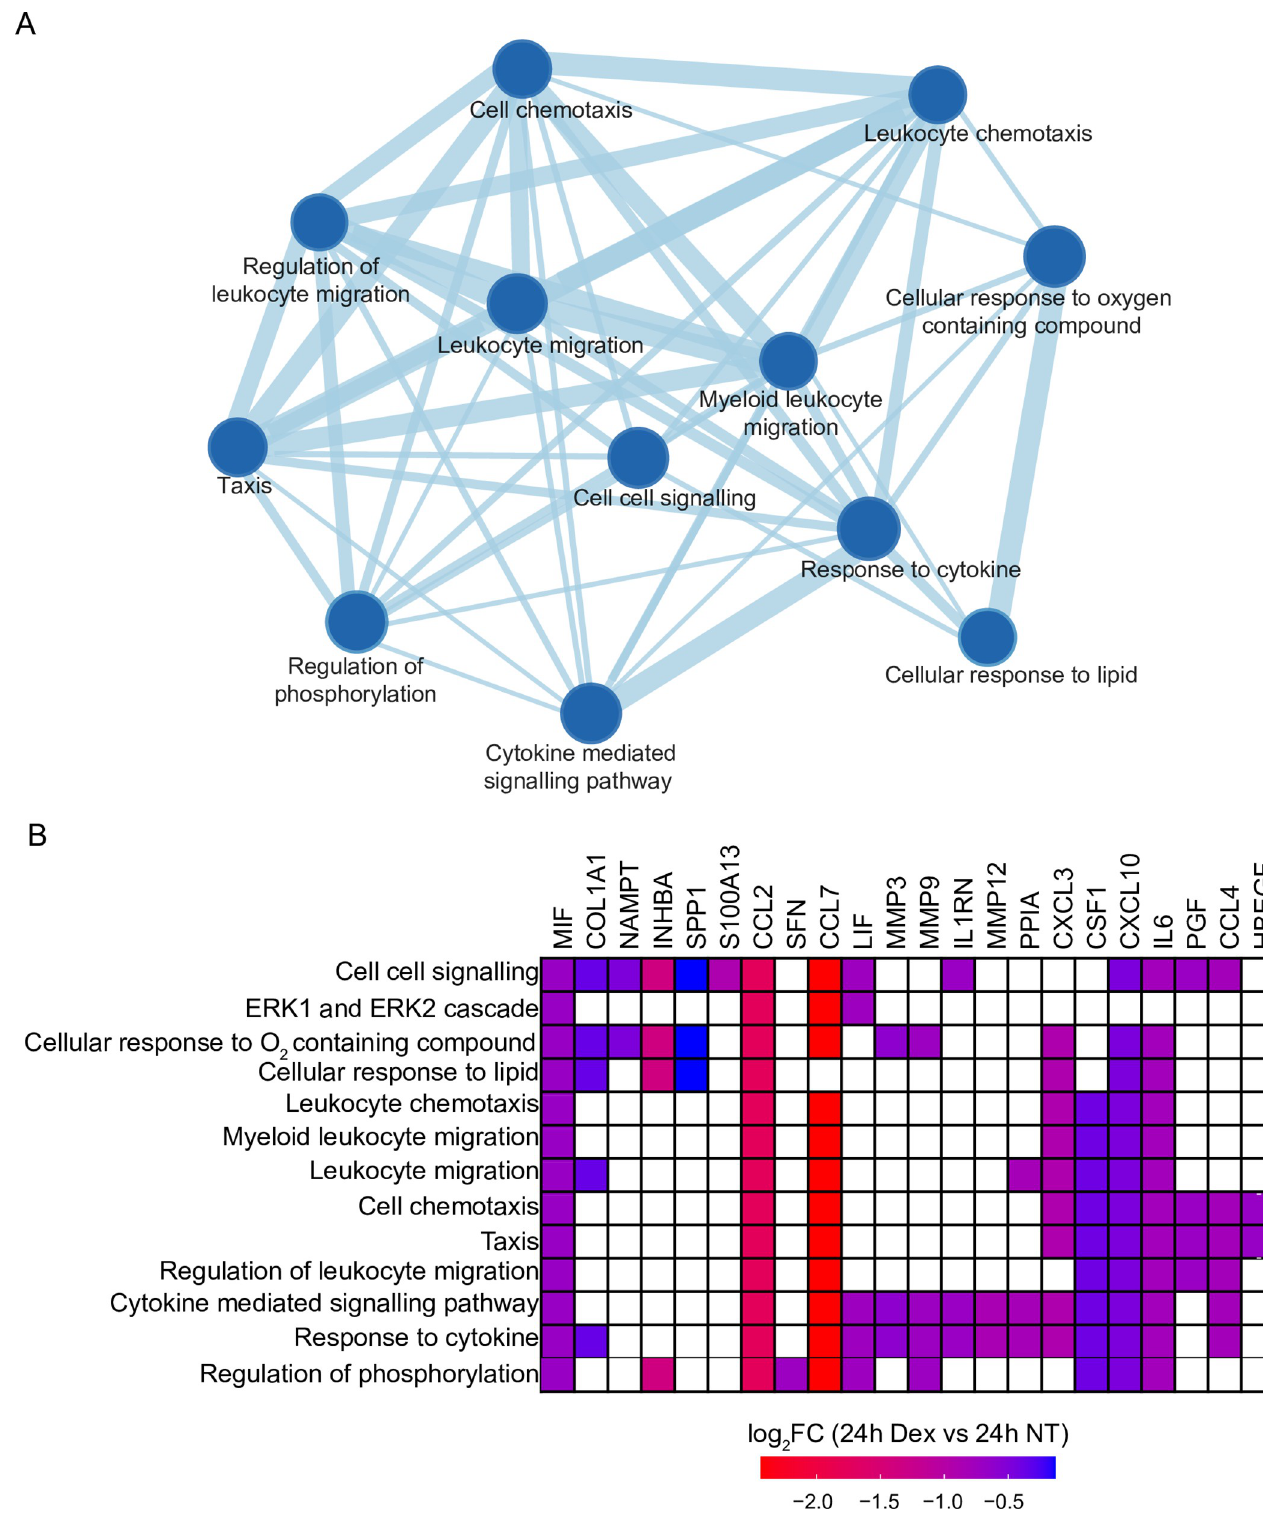
Fig 5. Gene set enrichment analysis (GSEA) of rat LSEC secreted proteins. GSEA leading-edge analysis including only proteins in the LSEC culture supernatants that were annotated as secreted proteins (n = 115) in the Human Protein Atlas [60]. (A) GSEA map showing processes that were significantly changed (all were downregulated) in the presence of Dex. The line thickness reflects the relative number of proteins that were affected. (B) Heatmap